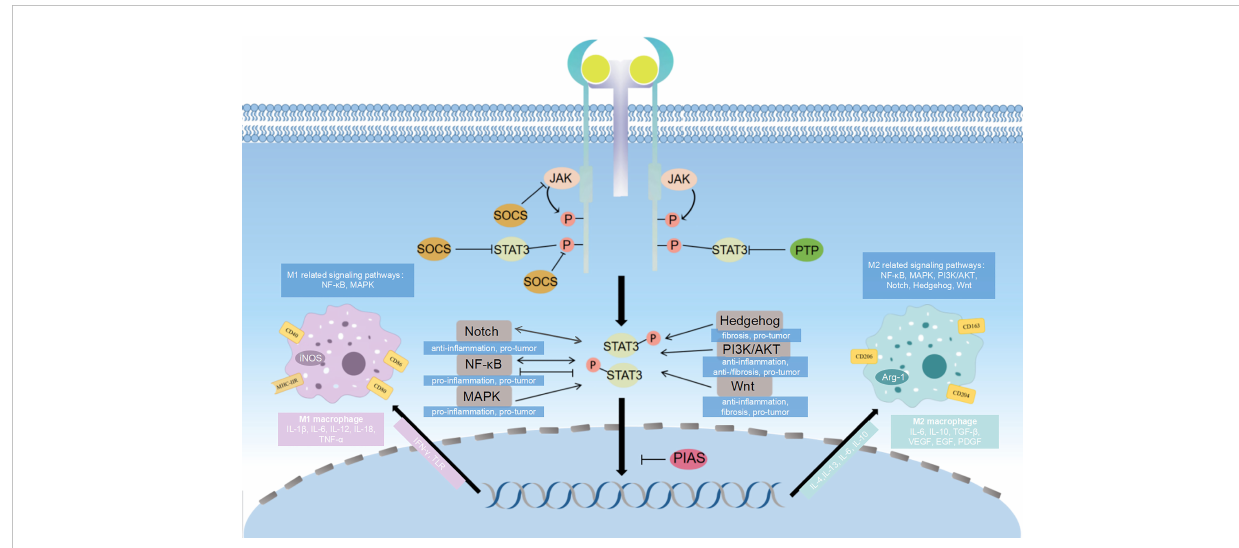
FIGURE 2 Diagram of signaling pathways related to STAT3 and macrophage polarization. STAT3 in fl uence macrophage polarization through different signaling pathways. The major pathway associated with STAT3 is JAK/STAT signaling pathway, and SOCS, PIAS and PTP can inhibit different targets of this signaling pathway, which ultimately affects the direction of macrophage polarization. The NF- k B signaling pathway, PI3K/AKT signaling pathway, Notch signaling pathway, Hedgehog signaling pathway, Wnt signaling pathway and MAPK signaling pathway crosstalk with JAK/STAT3 signaling pathway, which regulates gene transcription and have effects on macrophage